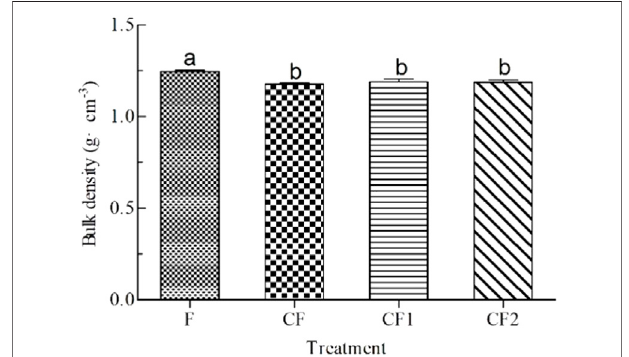
FIGURE 1 | Effect of co-application of biochar and chemical fertilizer on soilbulkdensity.Note:thehistograminthe fi gurerepresentstheaveragevalue and standard deviation of each treatment; Lowercase letters represent multiple comparisons of different treatments ( p < 0.05), the same below.